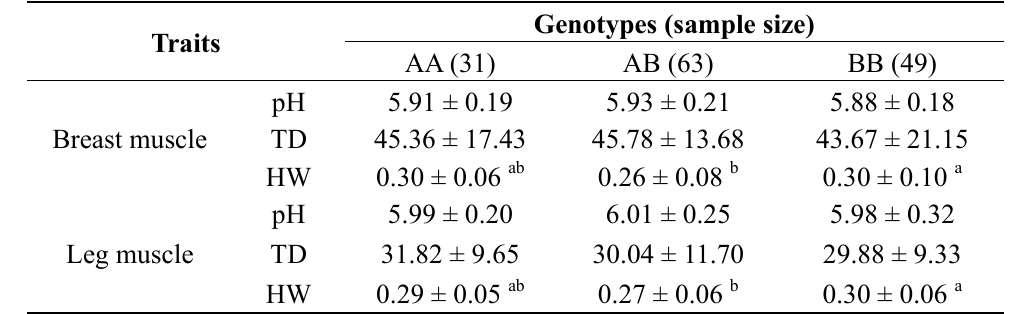
Table 4. Meat quality of genotypes of exon 2 of the GH gene. Data are expressed as the least-squares mean ± SE. a,b Means with different superscripts are significantly different ( p < 0.05). TD, tenderness; HW, water-holding capacity.